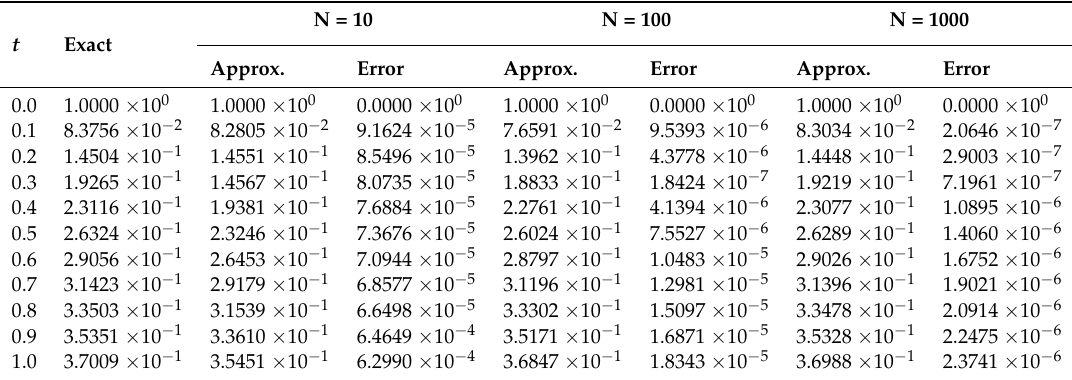
Table 8. Approximate solutions and absolute errors at each point, t when α = 1.0 for solving Example 4 by using FEAM3 at different intervals, N .